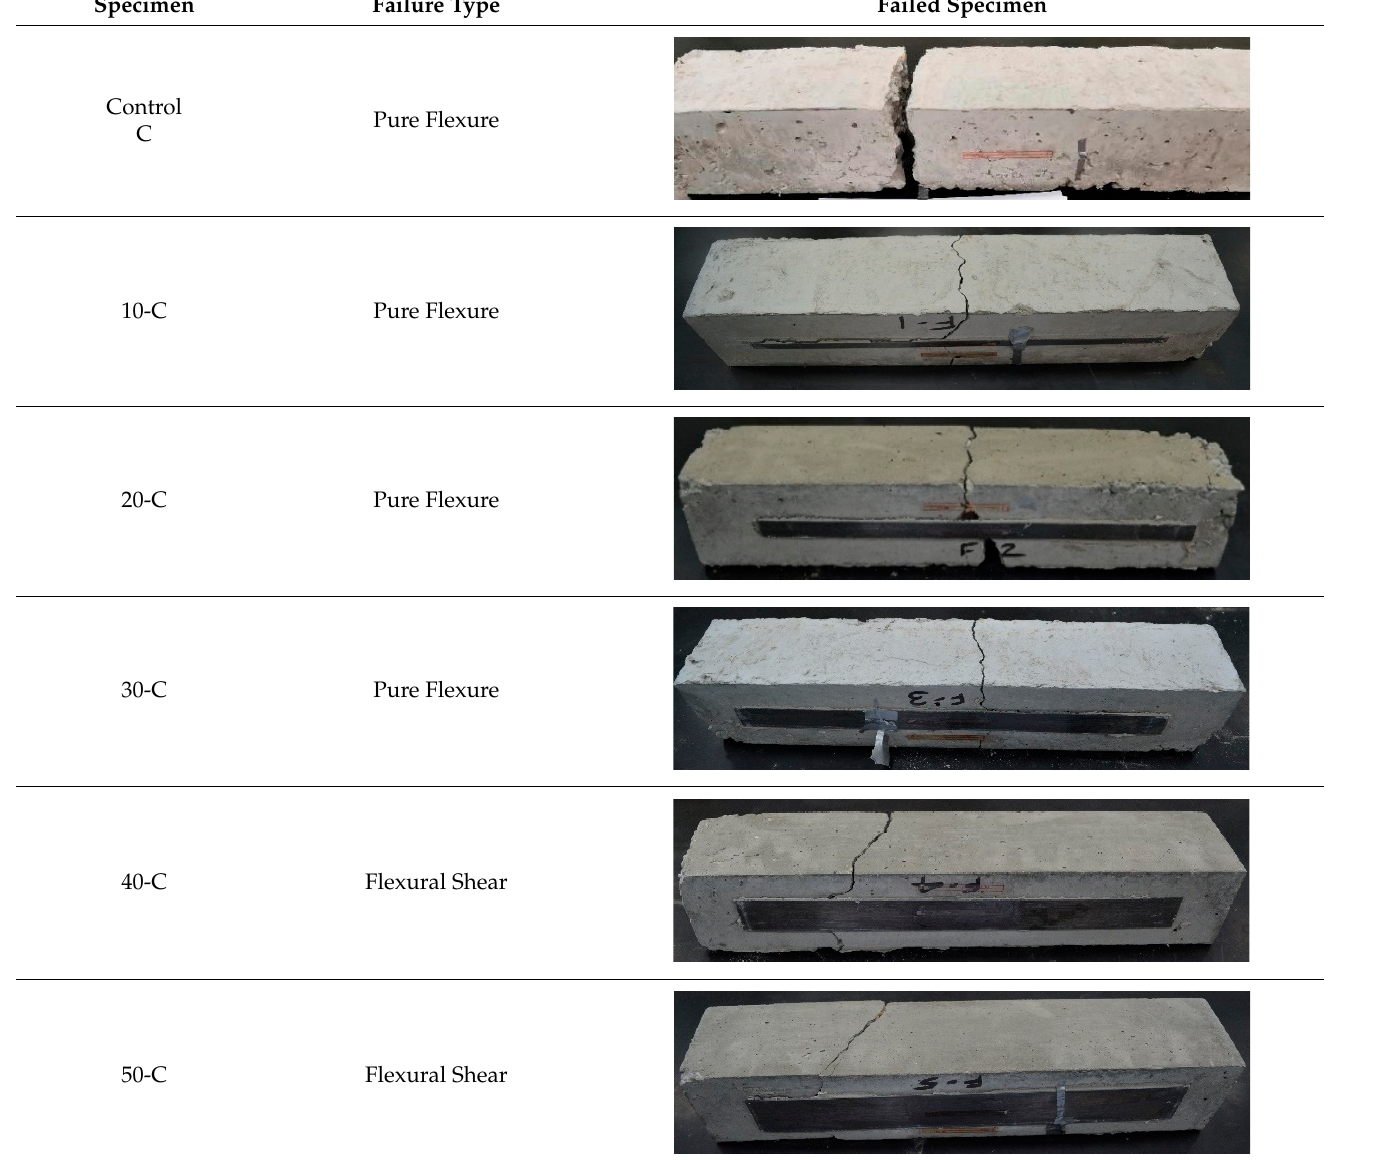
Table 7. Failure pattern of the tested beam samples.